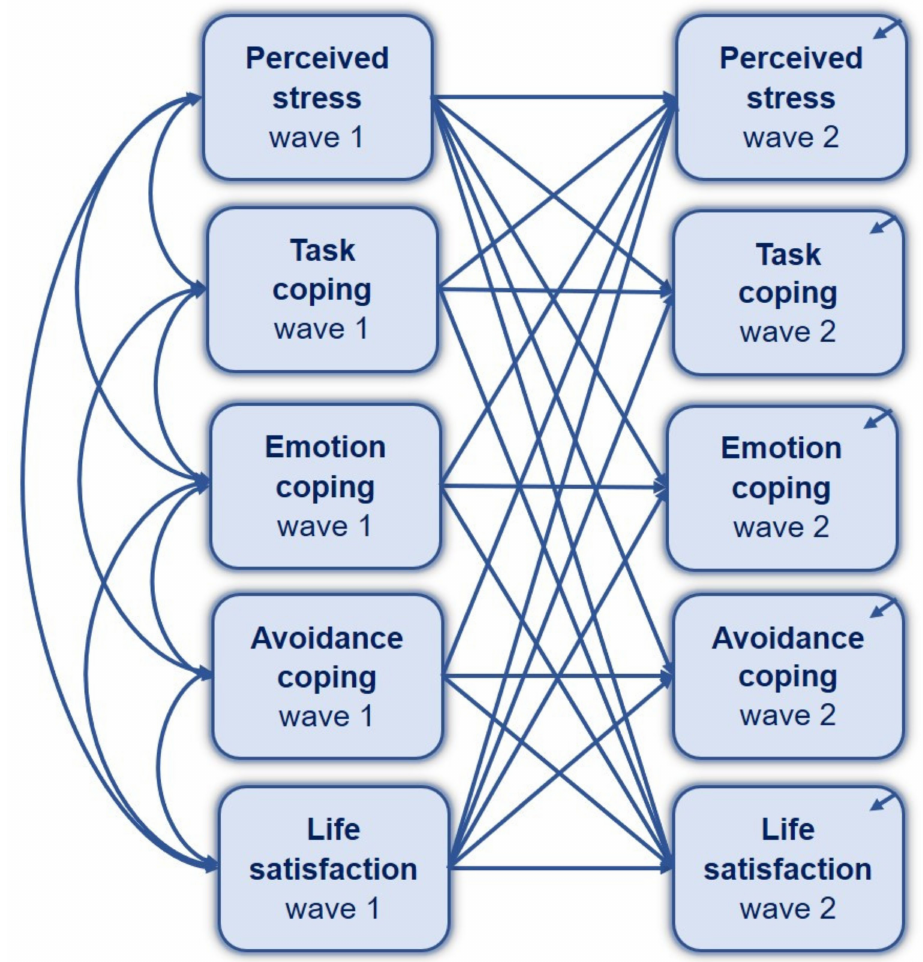
Figure 6. Conceptual reciprocal cross-lagged path model for a prospective study on the parallel mediation role of coping styles in the relationship between perceived stress and satisfaction with